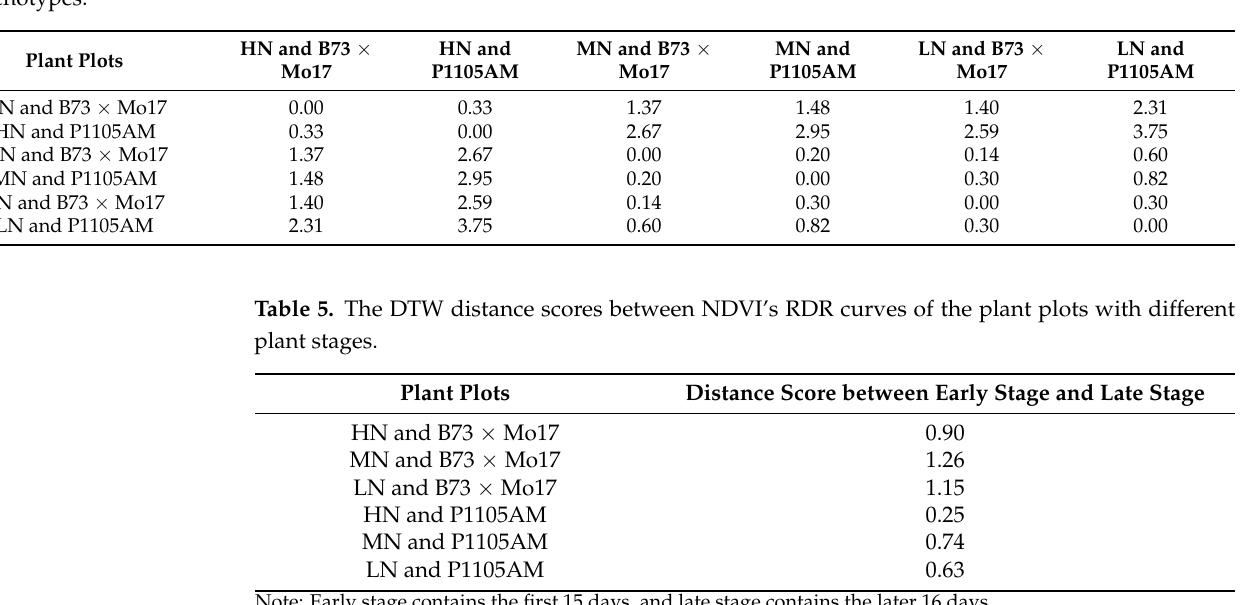
Table 4. The DTW distance scores between NDVI’s RDR curves of the plant plots with different nitrogen treatments and genotypes.